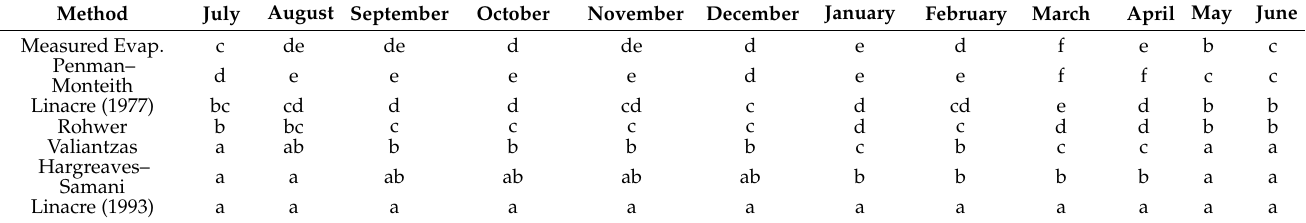
Table 3. Kruskal–Wallis test results for the evaporation values obtained by the methods and measured evaporation